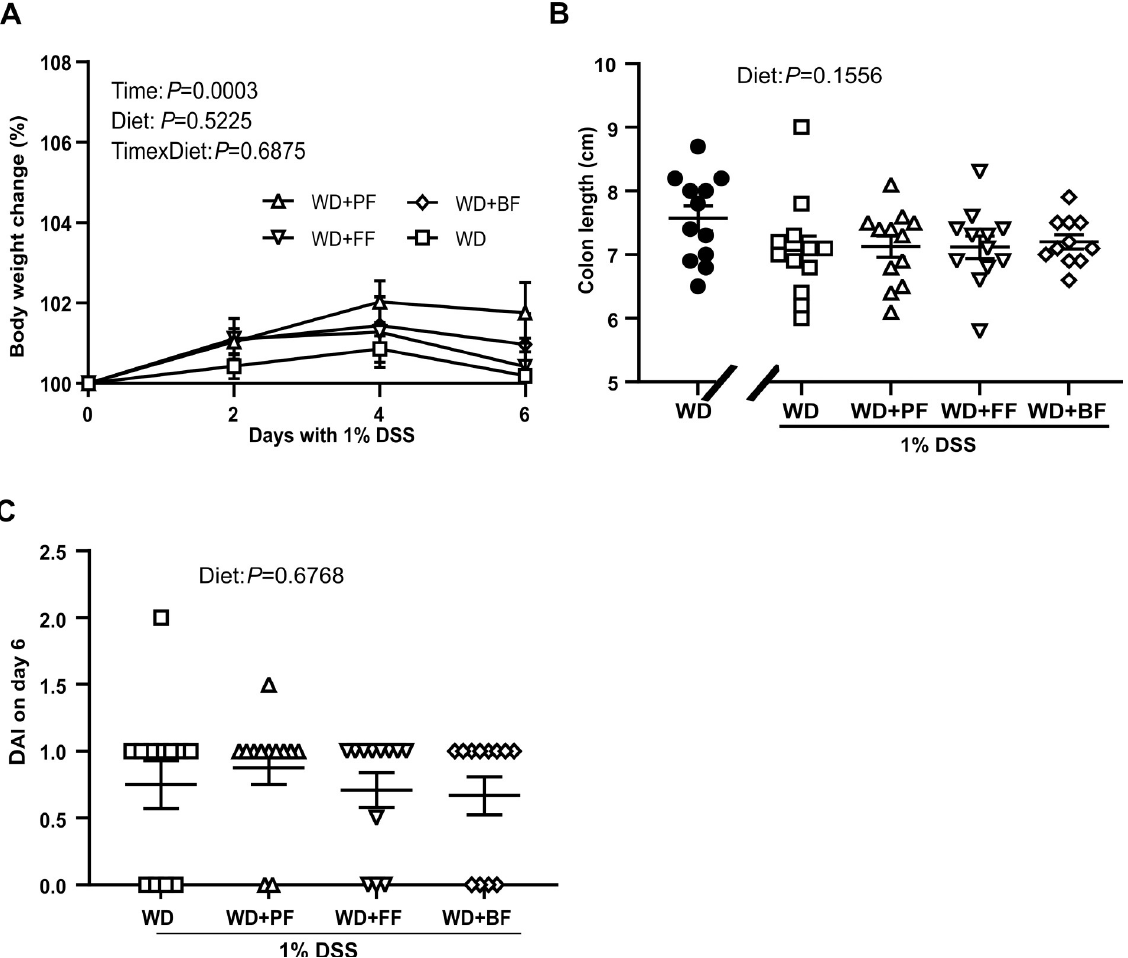
Fig 3. Bodyweight (%) development during 1% DSS in WD fed C57BL/6JRj mice during 6-days treatment. Change in bodyweight (%) measured on day 0, 2, 4 and 6 (3A) . Colon length in cm (3B) . Control mice indicated by black circles in the figure. For panel A 2-way ANOVA was used whereas for panels B and C one-way ANOVA and Kruskal Wallis test, respectively. Values are mean ± SEM. DAI score on day six of 1% DSS treatment (3C)